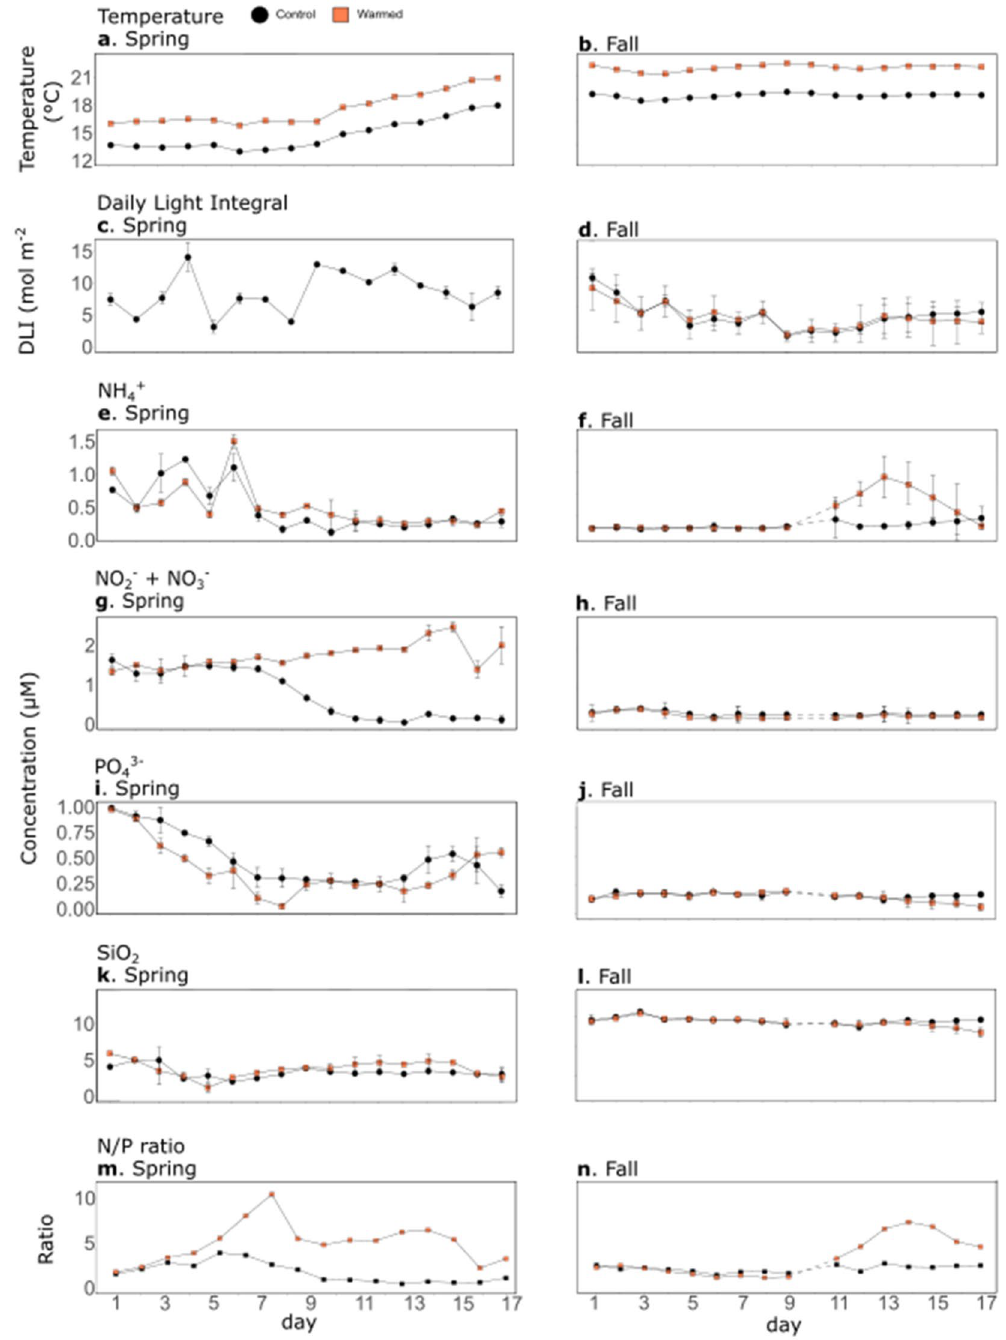
Figure 1. Time series of physical and chemical variables. Water temperature ( a , b ), Daily Light Integral (DLI, c , d ), ammonium (NH 4+ , e , f ), nitrates (NO 3− + NO 2− , g , h ), orthophosphate (PO 43− , i , j ), silicate (SiO 2 , k , l ) concentrations, and N/P ratio ( m , n ) over the course of the spring ( a , c , e , g , i , k , m ) and fall ( b , d , f , h , j , l , n ) experiments in the control (black) and the warmed (orange) treatments. Error bars represent range of observation for the two mesocosms per treatment in spring and the standard deviation for the three mesocosms per treatment in fall. Dotted lines represent the missing data on d10 of the fall experiment due to bad weather conditions. Due to technical difficulties, DLI could not be calculated in the warmed mesocosms of the spring